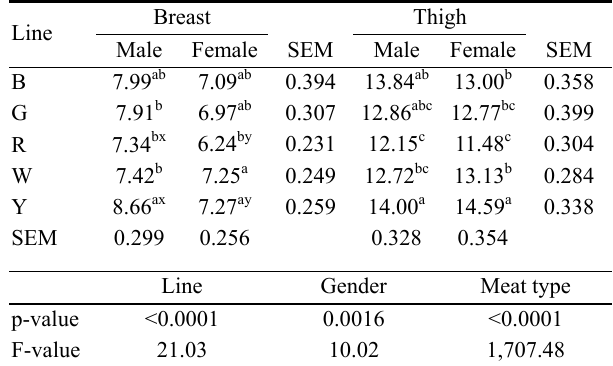
Table 3. L -carnitine content (mg/100 g) of breast and thigh meat from Korean native chicken breeds